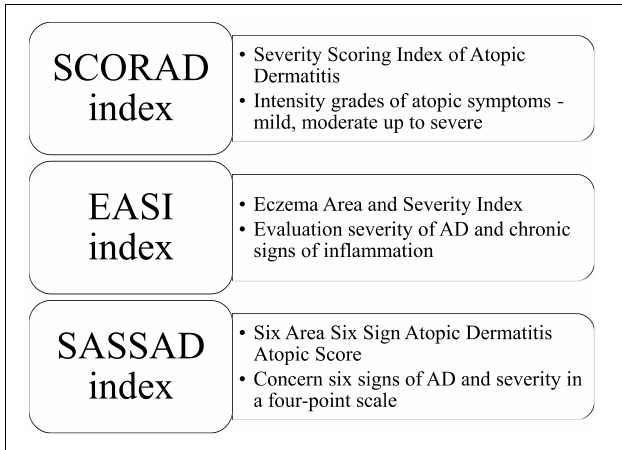
FIGURE 1 | Various scoring systems for diagnosing atopic dermatitis.